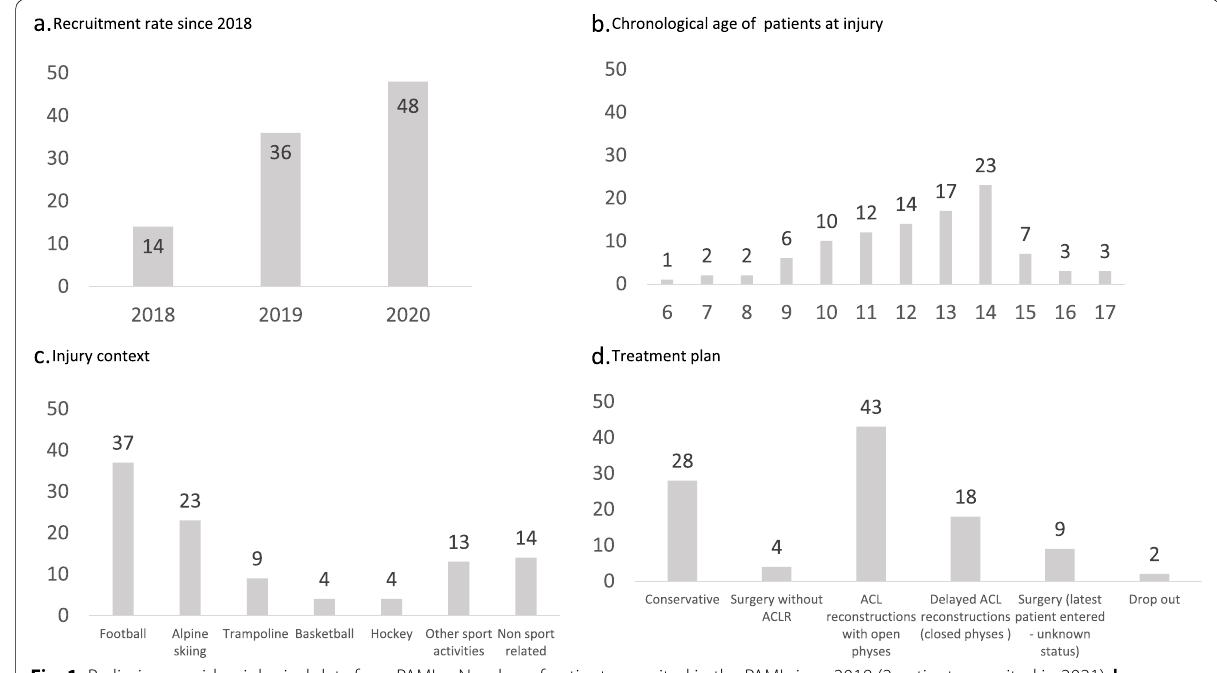
100 patients). c Injury context ( n =